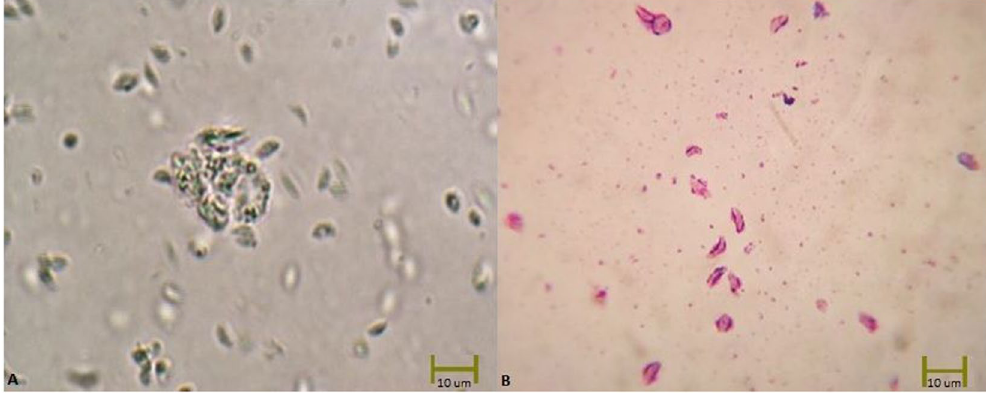
Figure 5. Microscopic images of T . gondii tachyzoites ( A ). Unstained (x40) ( B ). Stained with Giemsa